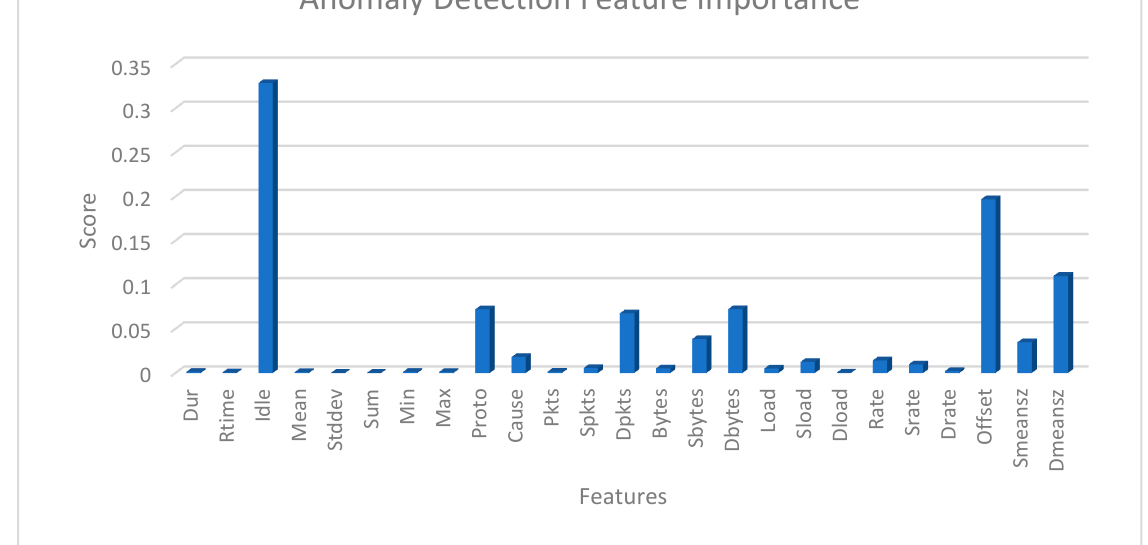
Figure 4. Feature importance for intrusion detection.